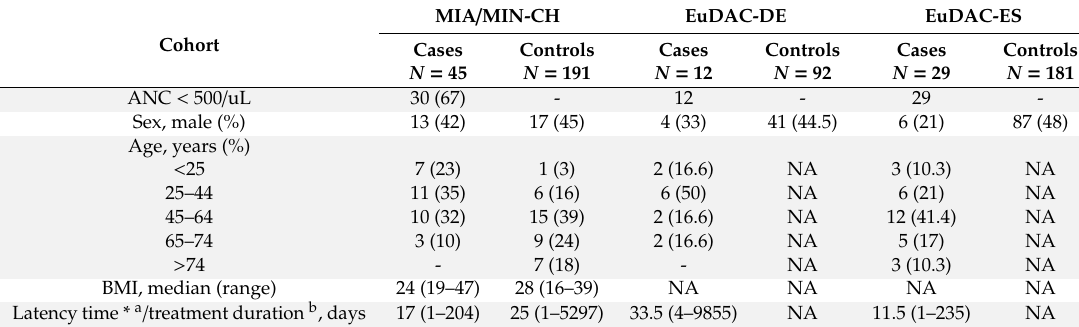
Table 1. Characteristics of cases and controls in the three independent cohorts. Data are N(%) or median (range). a cases, b controls, * latency missing for 3 MIA cases and 1 MIN case. ANC = lowest absolute neutrophil count, BMI = body mass index, NA = not applicable / not